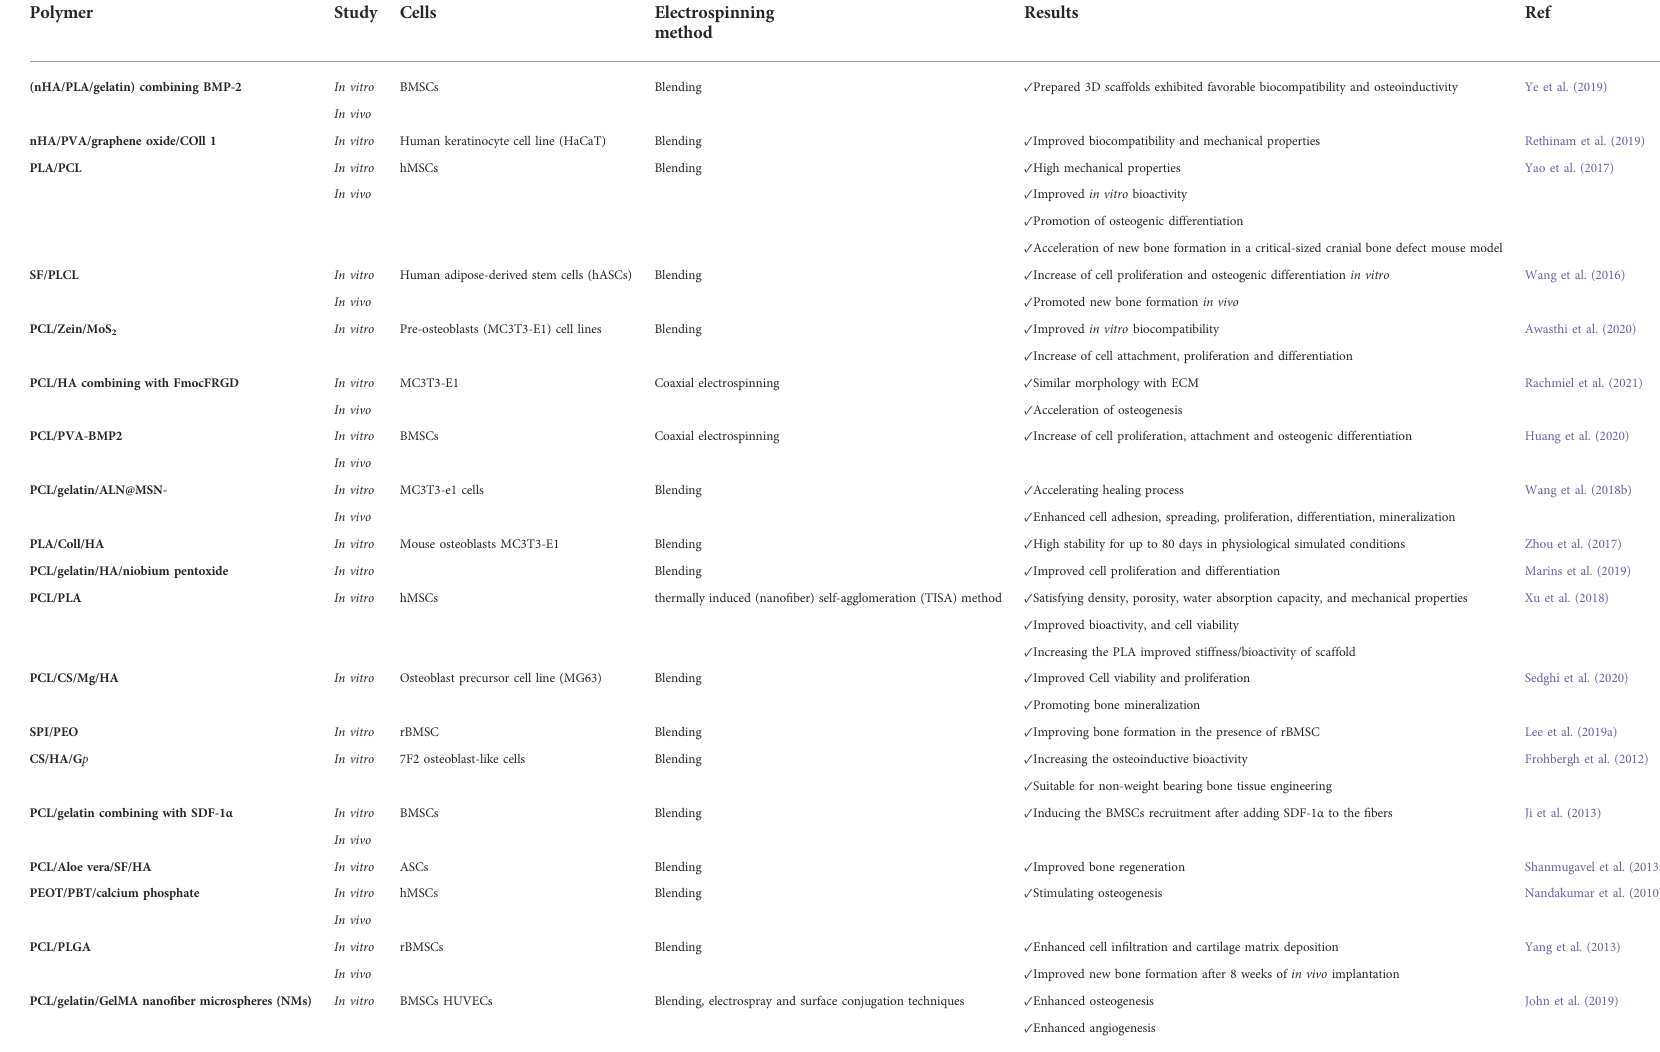
TABLE 4 An overview of electrospun hybrid nano fi ber for bone tissue